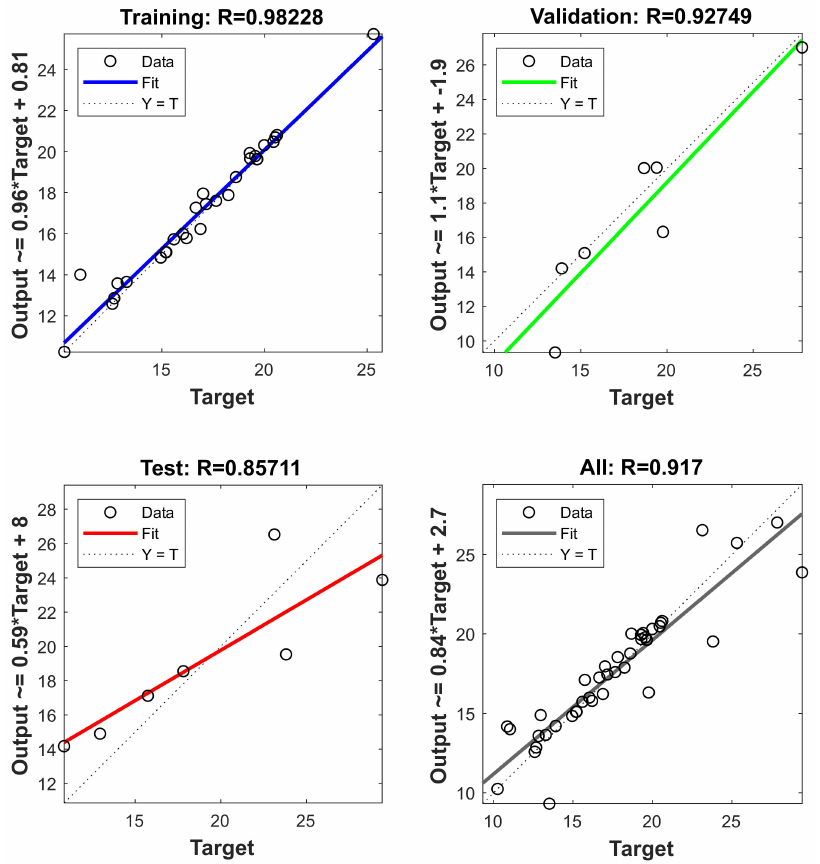
Figure 11. Regression plots for ultimate tensile strength obtained using the ANN model. Table 8. Comparative evaluation of predictive